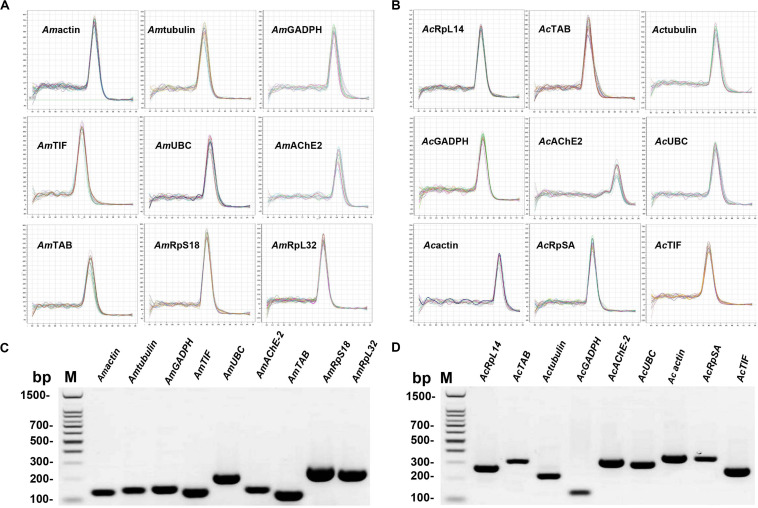
Confirmation of primer specificity and amplicon size. (A) Melting curve analysis of the Apis mellifera candidate reference genes. All RT-qPCR products had a single melting curve indicating the breakdown of only one PCR product. (B) Melting curve analysis of Apis cerana candidate reference genes. All RT-qPCR products had a single melting curve indicating only one PCR product. (C) Amplification results for Apis mellifera candidate genes from cDNA template. (D) Amplification results for Apis cerana candidate genes from cDNA template. M: DL1500 DNA marker.